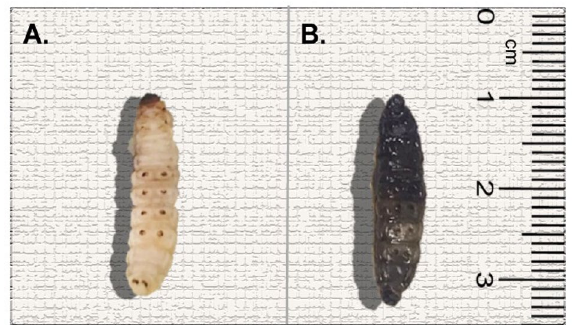
Figure 7. PBS-injected control larva ( A ) and E-faecalis infected larva ( B